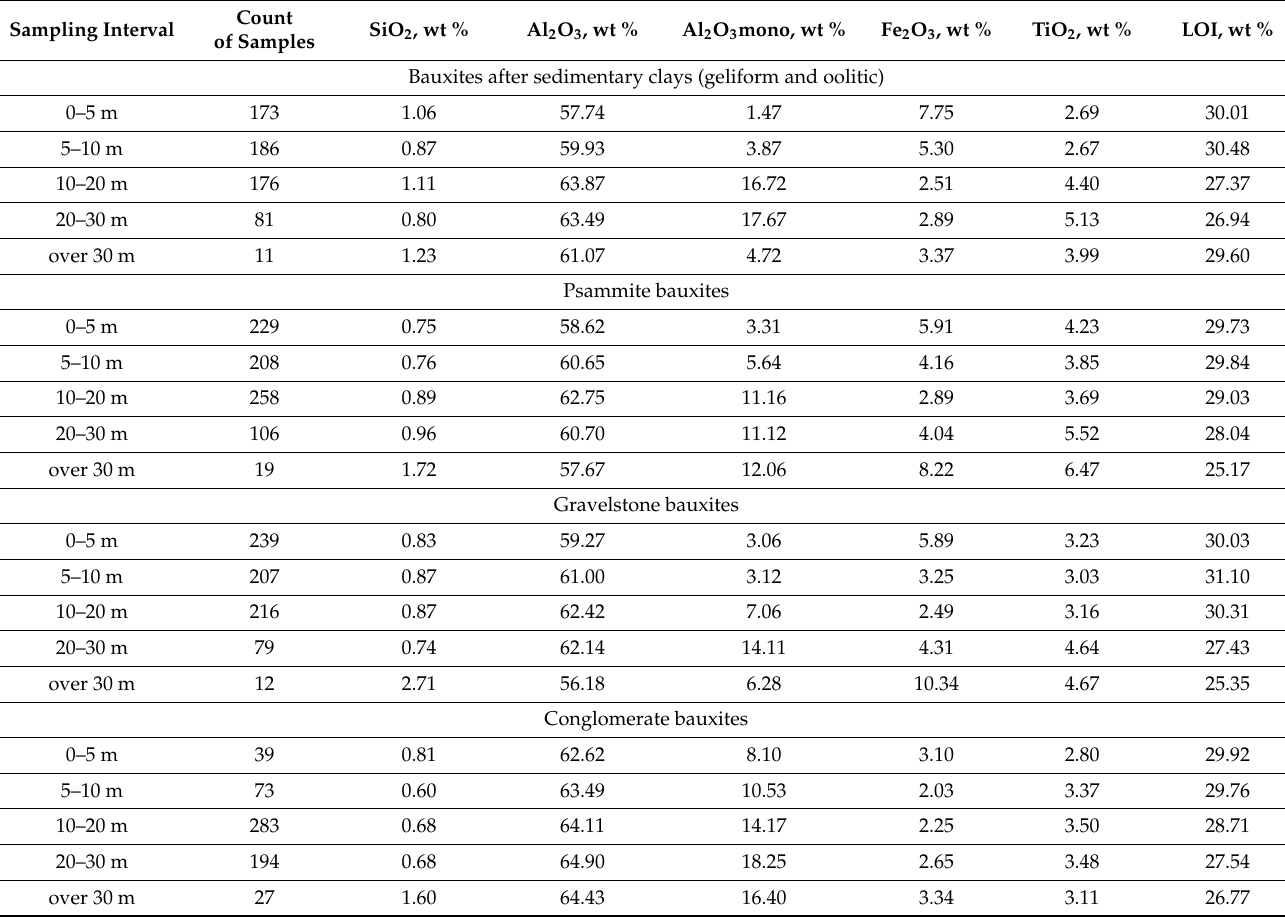
Table 1. The average chemical composition of bauxites of the Sangaredi District of various lithological types with consideration of their depth of